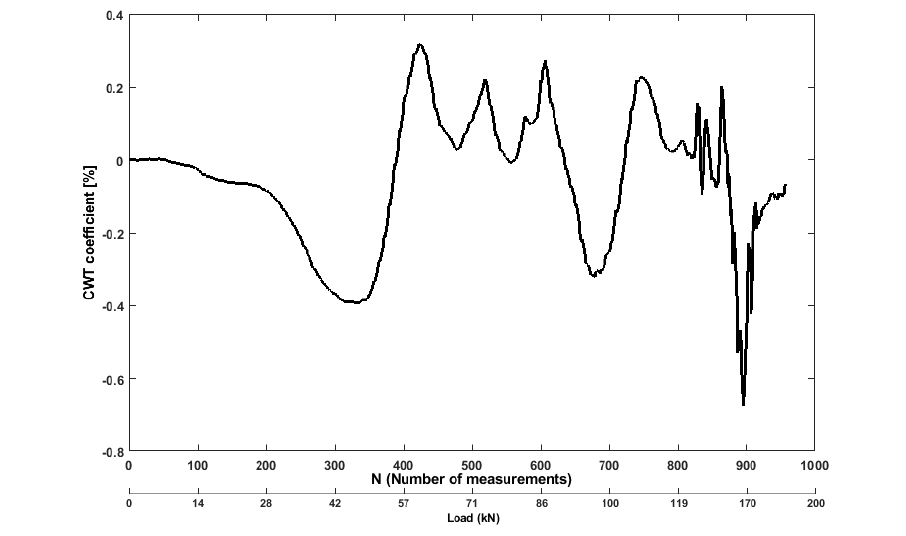
Figure 15. Values of CWT coefficient feature from ultrasonic pair S01R04 time histories.